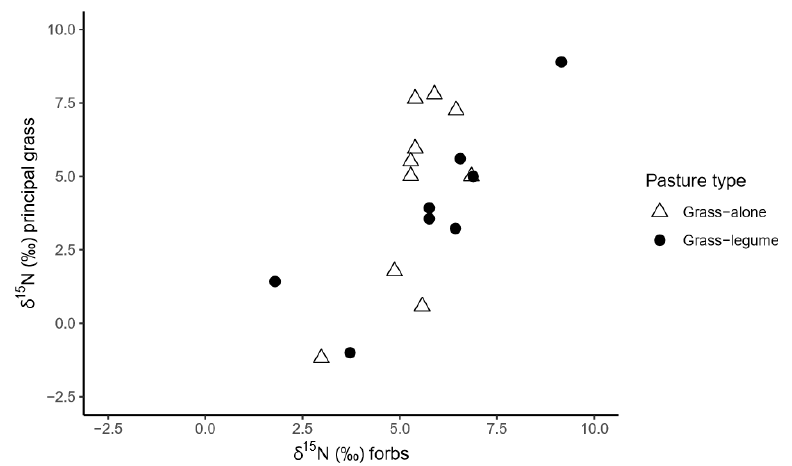
Figure 2. Relationship between shoot δ 15 N signature of forbs and principal grasses sampled in grass-alone (open triangles, n = 10) and grass-legume (full circles, n = 8) pastures. Pearson’s correlation coefficient (r) = 0.76, p < 0.01.